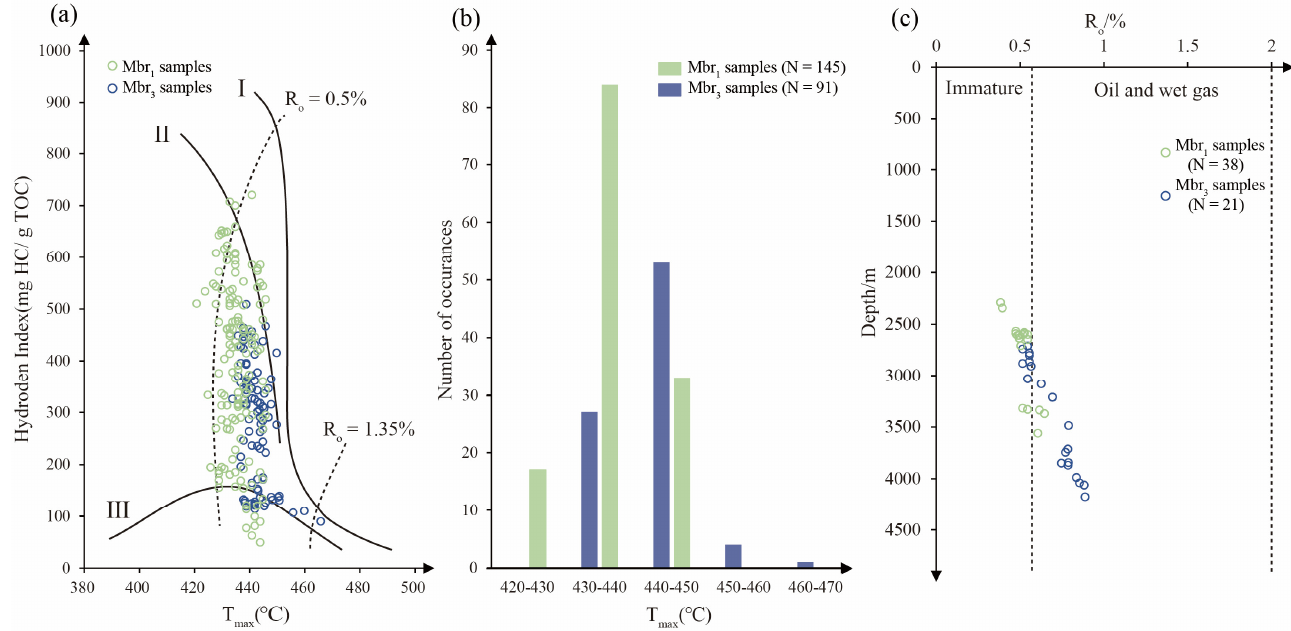
Figure 6. Organic geochemistry characteristics of the Mbr 3 source rock samples; ( a ) Plot of HI versus T max showing kerogen type and thermal maturity [35]; ( b ) Statistical histogram of kerogen maturity by T max (division standards from [28]); ( c ). Kerogen maturity assessed by R o (division standards from [4]).